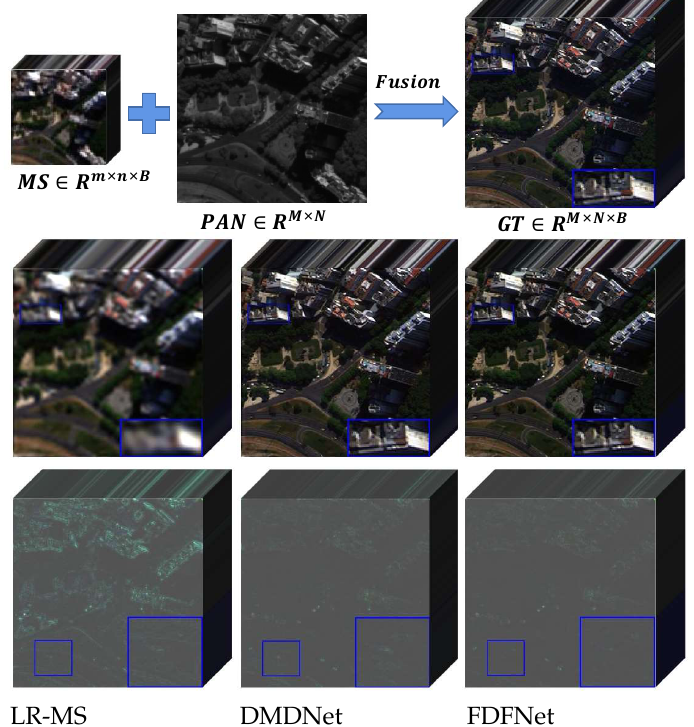
Figure 1. First row: Schematic diagram of pansharpening. Pansharpening aims to fuse a low spatial resolution multispectral (MS) image and the panchromatic (PAN) image, and the ground-truth image are presented. Second row: Results presentation. The fusion images and the corresponding absolute error maps of DMDNet [34] and the proposed